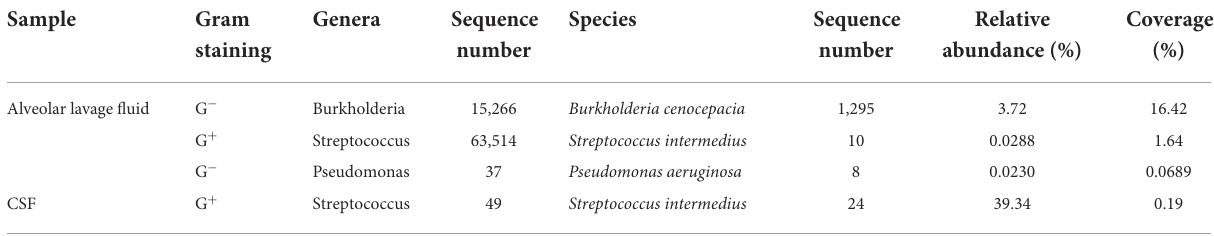
TABLE 1 List of macro genomic pathogens detected in alveolar lavage fluid and cerebrospinal fluid (CSF) samples on 5 days after admission.